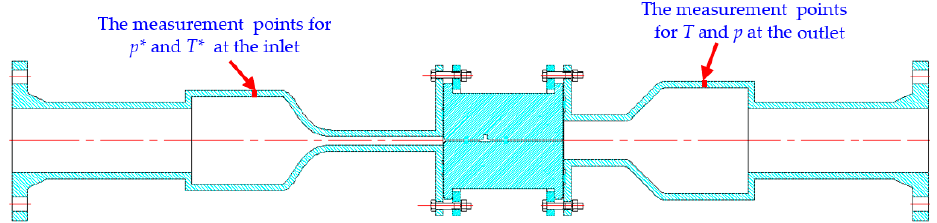
Figure 4. Schematic diagram of the locations of the experimental measuring points.